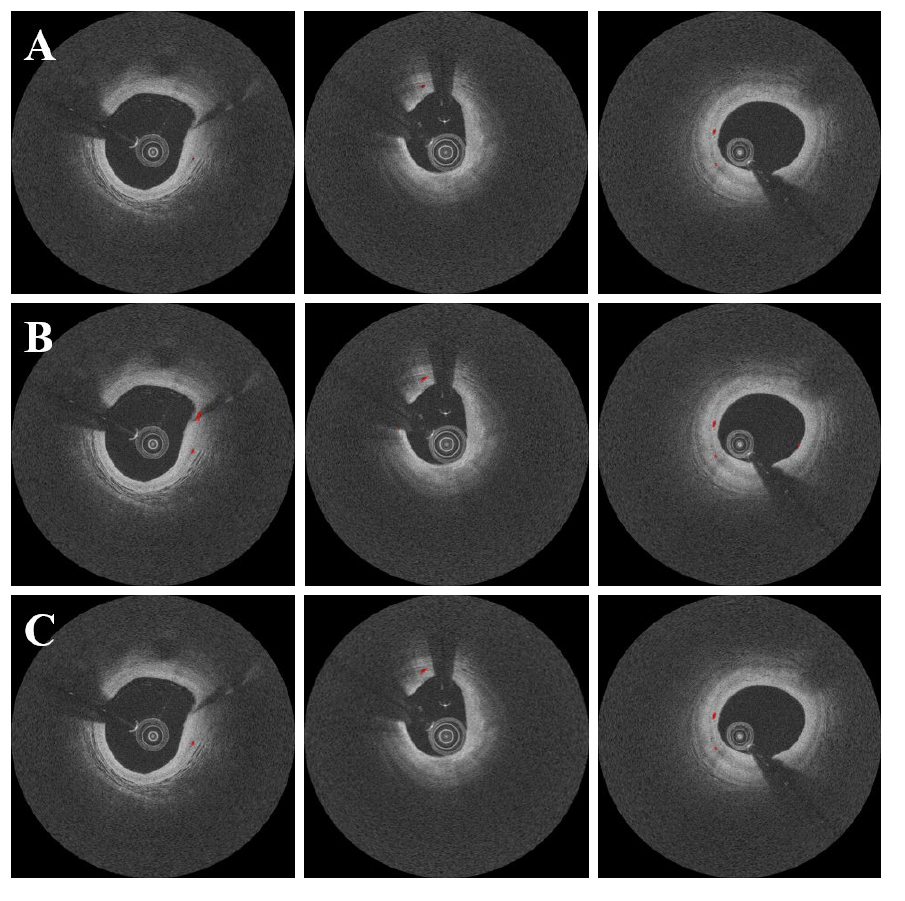
Figure 6. Segmentation results with and without the candidate classification step. Panels are as follows: ( A ) manual annotation, ( B ) results before candidate classification, and ( C ) results after candidate classification. There were some false positives from the candidate segmentation step ( B ), which were effectively ruled out with the candidate classification step ( C ). The red is a